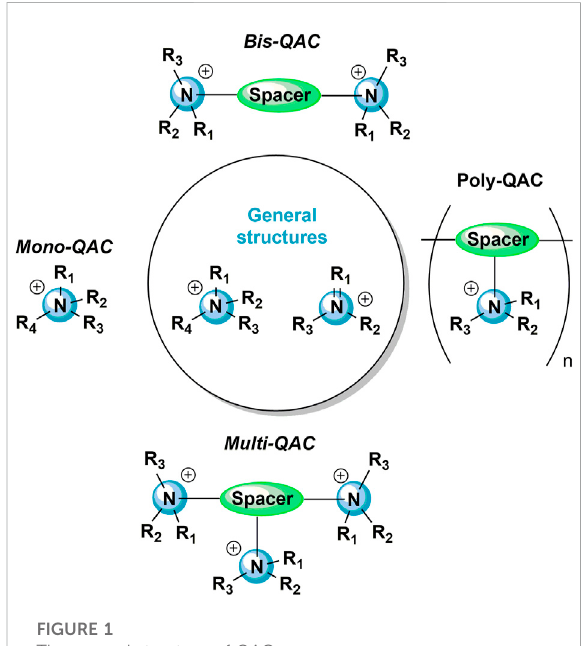
FIGURE 1 The general structure of